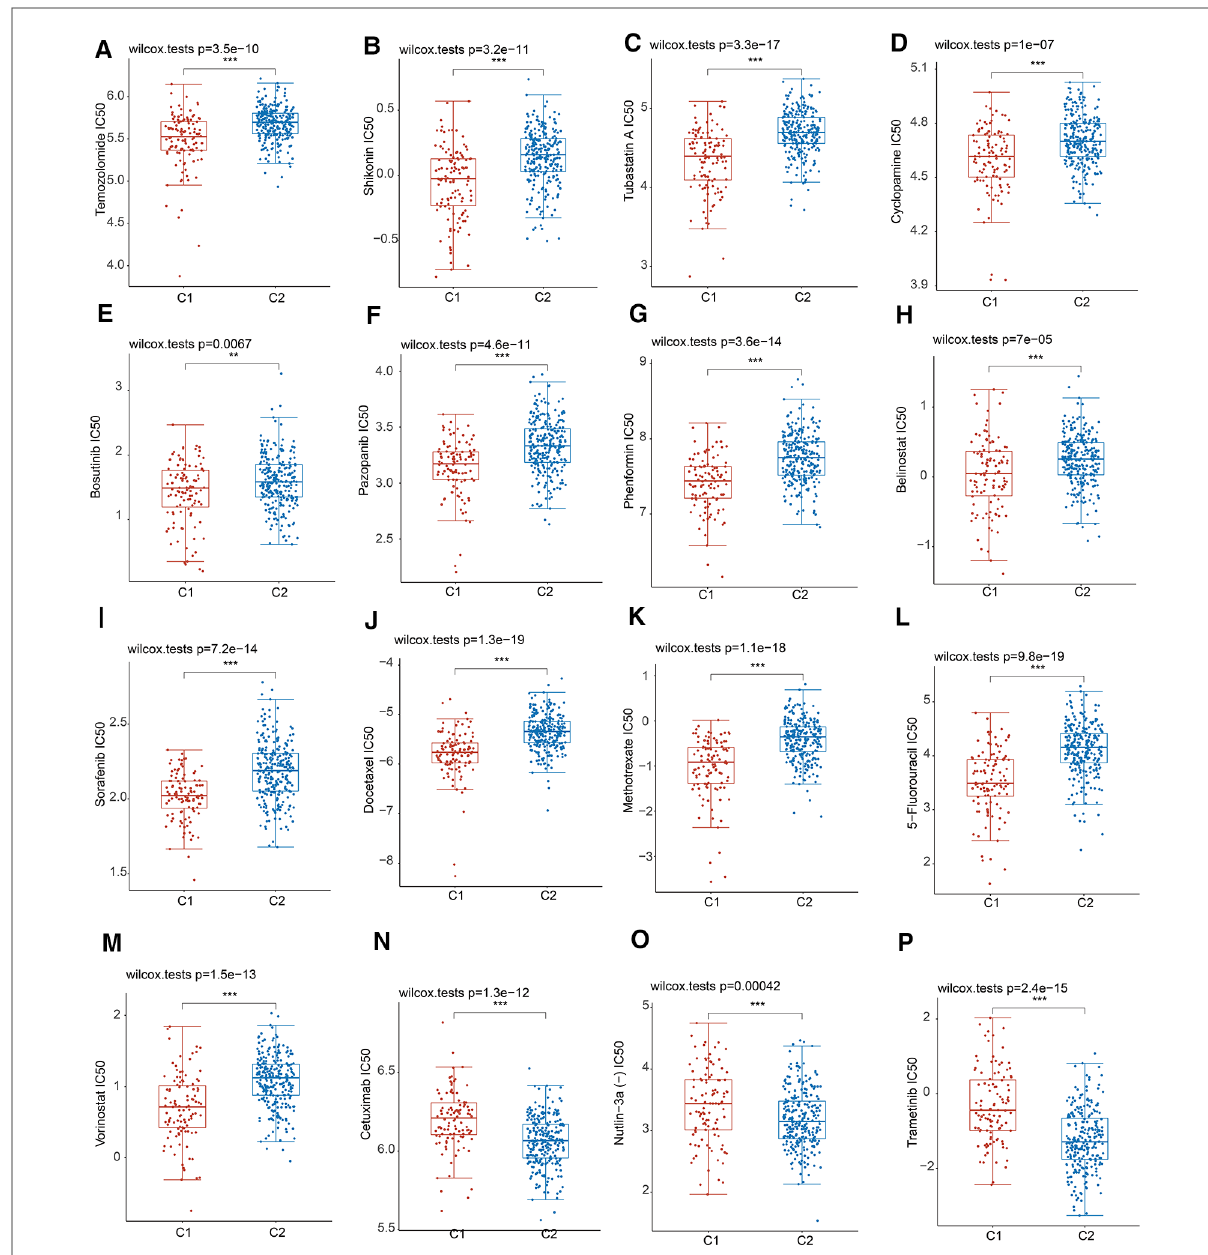
FIGURE 4 Drug sensitivity analysis in two MRPs groups. ( A ) Temozolomide. ( B ) Shikonin. ( C ) Tubastatin A. ( D ) Cyclopamine. ( E ) Bosutinib. ( F ) Pazopanib. ( G ) Phenformin. ( H ) Belinostat. ( I ) Sorafenib. ( J ) Docetaxel. ( K ) Methotrexate. ( L ) 5-Fluorouracil. ( M ) Vorinostat. ( N ) Cetuximab. ( O ) Nutlin-3a ( − ). ( P )